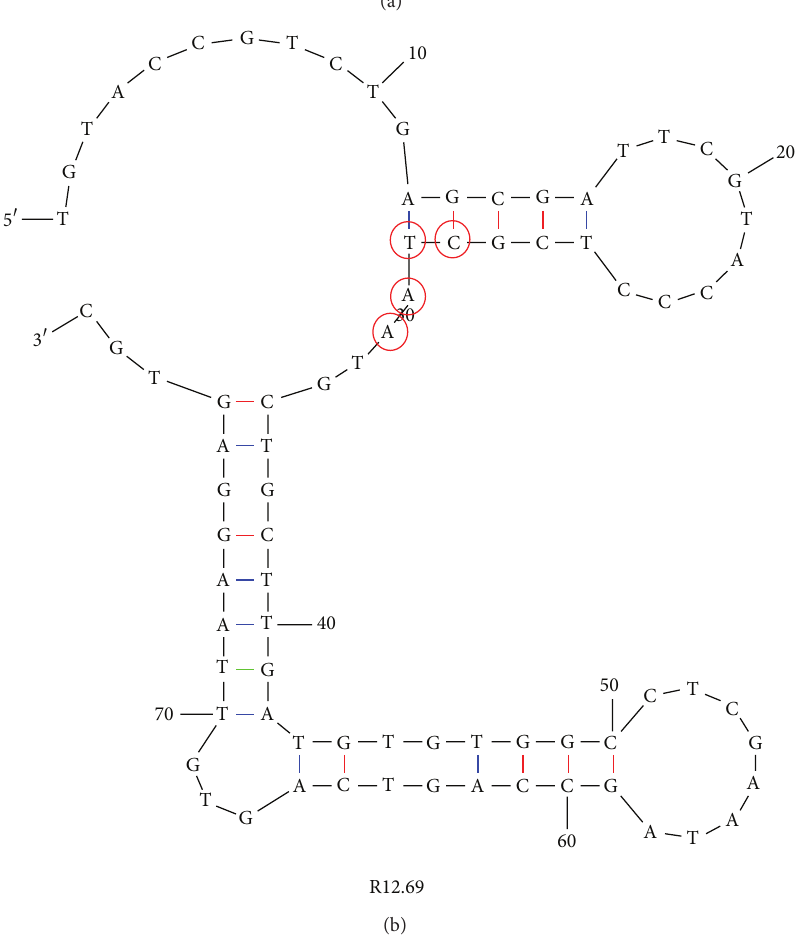
Figure 5: Secondary structure and sequence of R12.69 ssDNA MRE. (a) ssDNA sequence of toxin B MRE R12.69. The red portions indicate the constant regions for primer attachment, and the black portion indicates the variable region. (b) Mfold prediction of R12.69 secondary structure. Highlighted sequence, CTAA, represents most common tetranucleotide sequence in the variable regions of the 43 sequences obtained from the round 12 library, and it is used as the center for sequence alignment in Figure 4 [33].